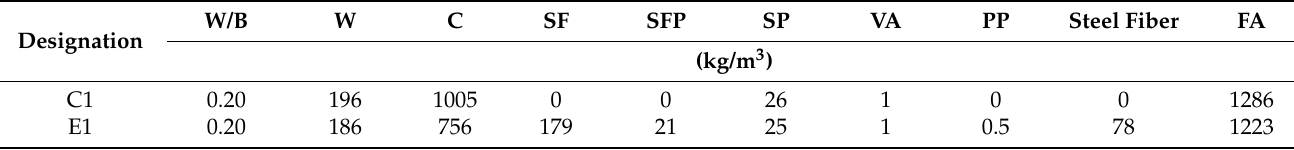
Table 5. The mix proportions of the concretes.